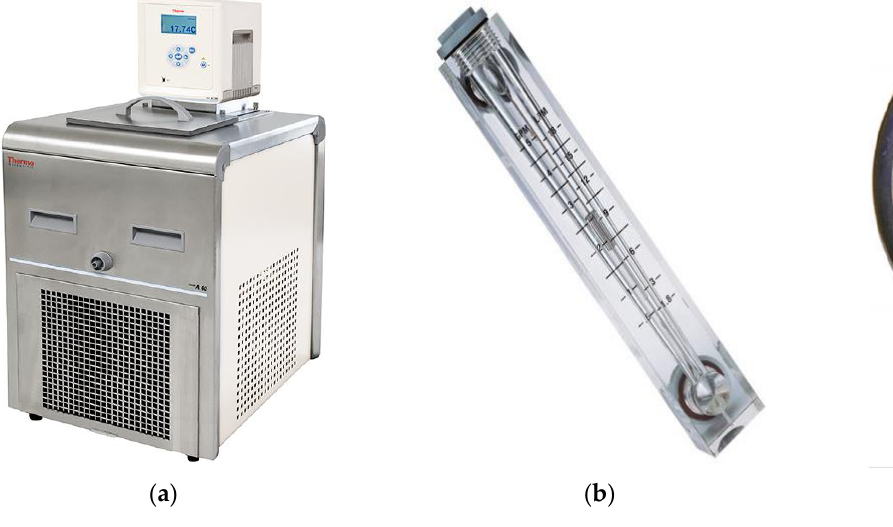
Figure 6. ( a ) Chiller with a built-in pump, ( b ) flow meters (Omega FL 50,000), and ( c ) Baumer pressure gauges.